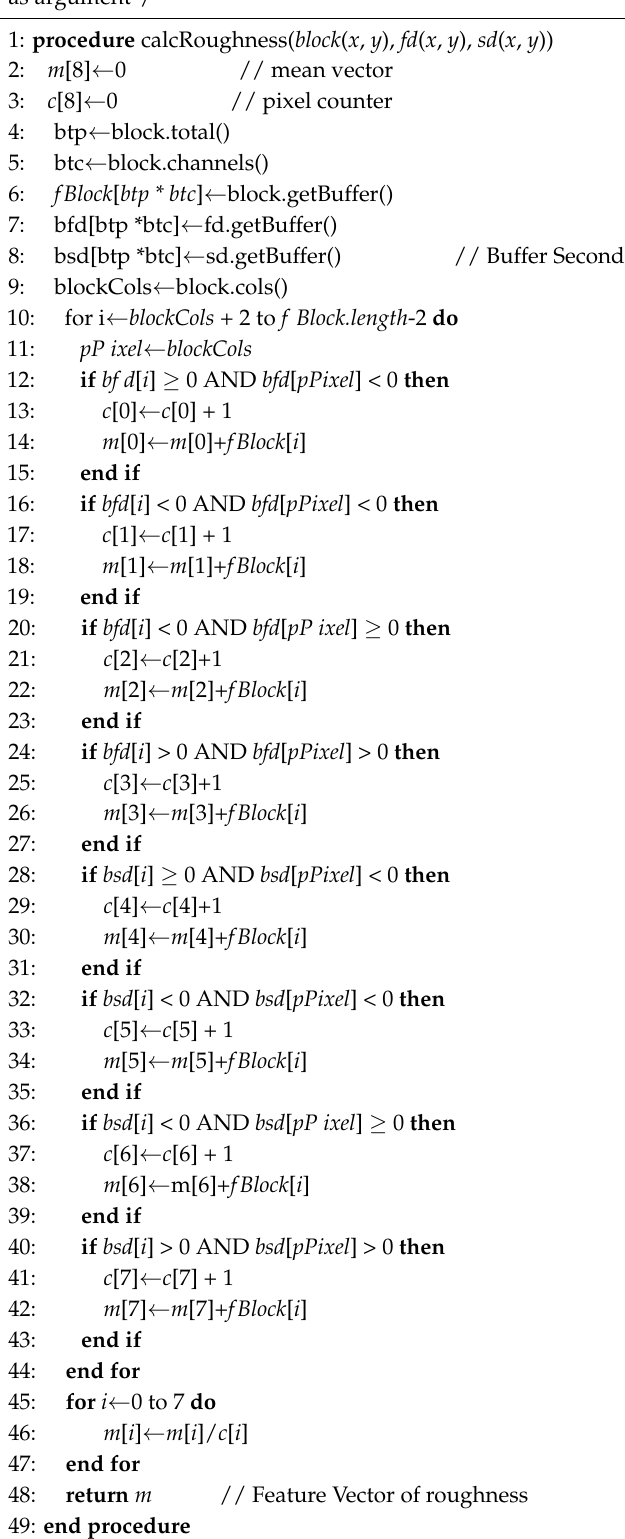
Algorithm 1. /* Pass original block of banknote, its first derivative, and second derivative